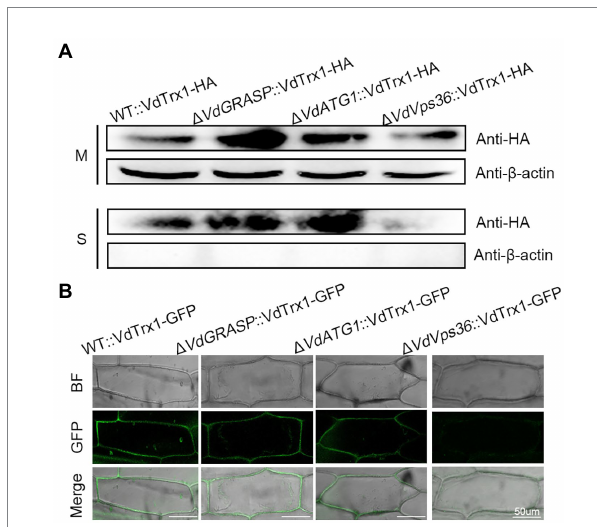
FIGURE 4 Secretion mechanism of VdTrx1 from V. dahliae . (A) Proteins extracted from mycelia (M) and culture supernatants (S) of strain WT::VdTrx1-HA, Δ VdGRASP ::VdTrx1-HA, Δ VdATG1 ::VdTrx1-HA and Δ VdVps36 ::VdTrx1-HA were analyzed using western blotting with anti-HA or anti- β -actin antibodies, as indicated. (B) The V. dahliae strains WT::VdTrx1-GFP, Δ VdGRASP ::VdTrx1-HA, Δ VdATG1 ::VdTrx1- HA and Δ VdVps36 ::VdTrx1-HA were used to inoculate onion epidermal cells, respectively, at room temperature for 5 days followed by confocal microscopy imaging. Bar, 50 μ m.